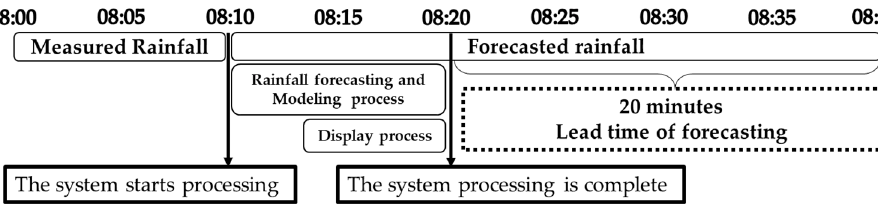
Figure 12. An example of the timeline of the RTFlood